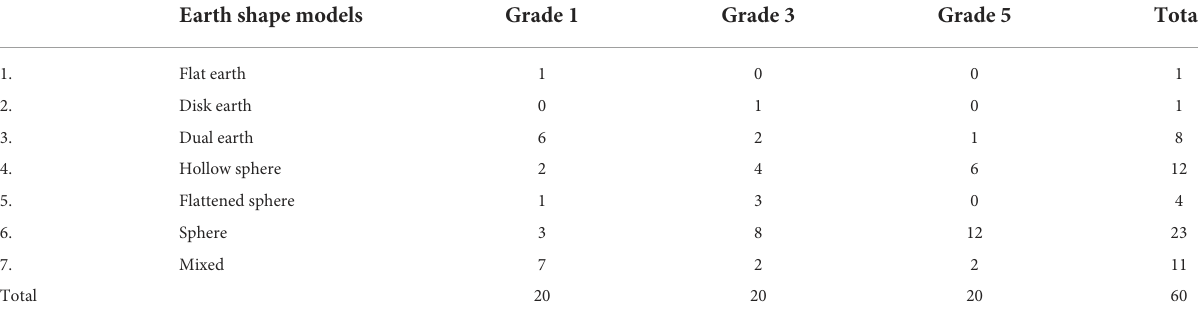
TABLE 4 Frequencies of different mental models of the shape of the Earth for children in Grades one, three, and five. Earth shape